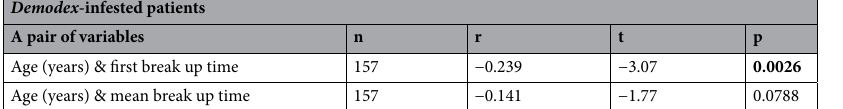
Table 8. Results of the significance the Pearson linear correlation between the age of the Demodex -infested patients and the first and mean break up times in both eyes. Pearson’s linear correlation coefficient (r), t-value (t), p-value (p). Significant value in